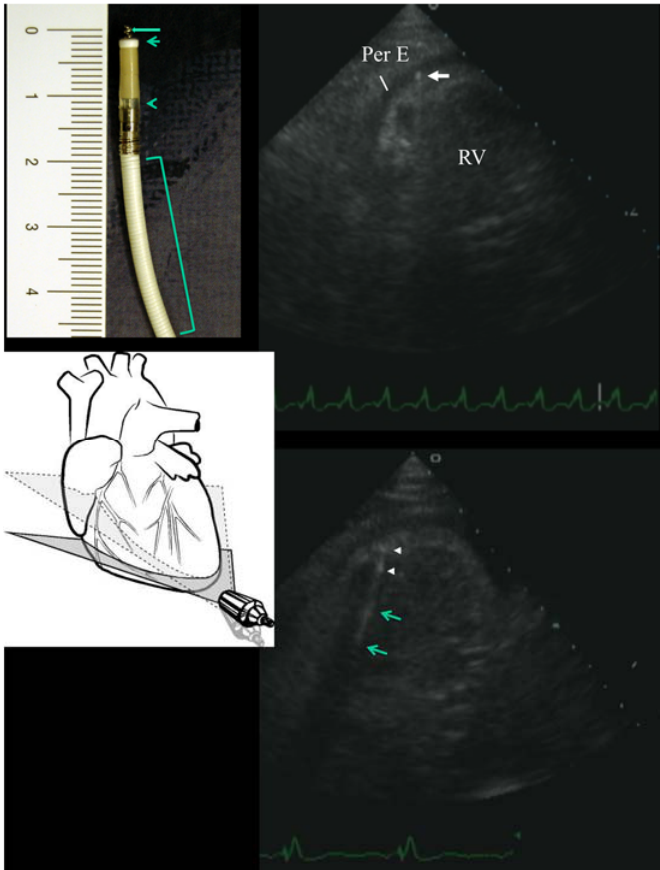
Figure 2. Right ventricular perforation by the ICD lead, visualized by transthoracic echocardiography, before and after lead repositioning. The upper part shows the modified 4-chamber view (the specific inclination of the tomographic plane to attain this plane is schematically shown in the diagram at the bottom left, where the dashed-line-delimited plane indicates the standard 4-chamber view plane orientation), that shows the tip of the wire (due to its minuscule structure, actually the helix) penetrating 2–3 mm into the fluid-filled pericardial space (on the upper left side, a photo of the distal part of the lead is reported, with its characteristics indicated: helix, the fixating screw (long arrow), tip electrode (short arrow), ring electrode (arrow head), and the distal defibrillator electrode (bracket)). The lower part shows the same echocardiographic view after unscrewing the helix, along with minimal lead retraction: no more protrusion of the lead into the pericardial space is visible; in addition, some hypereflective zones along the lead are visible by echo, that should correspond to the electrodes (arrow heads) and coils (arrows). RV = right ventricle; Per E = pericardial effusion.